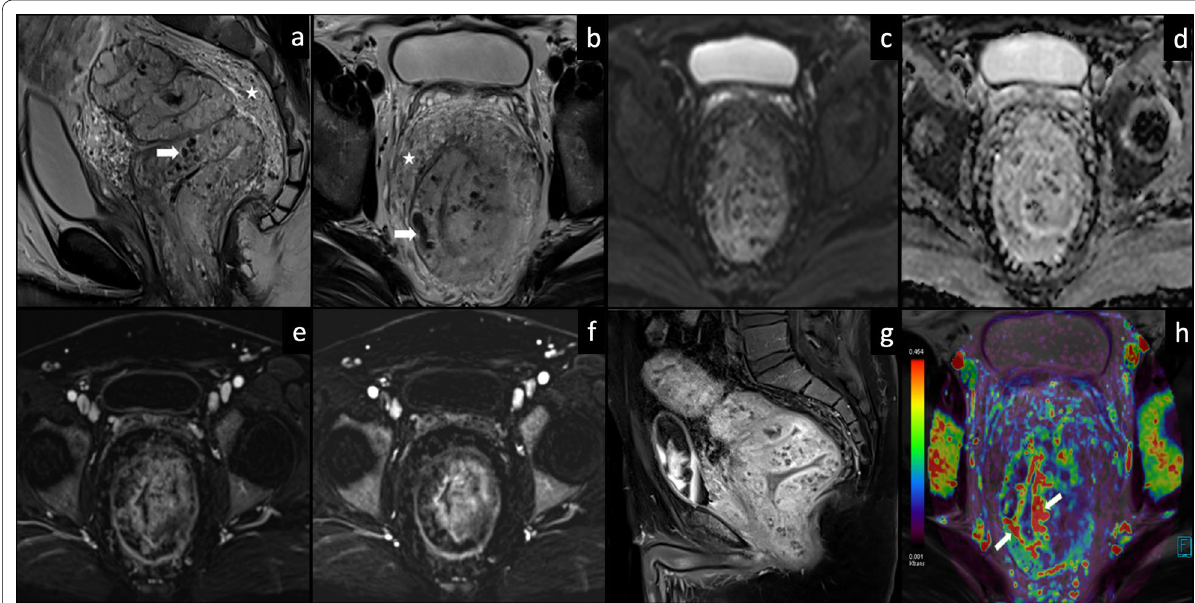
Fig. 2 The sagittal ( a ) and axial ( b ) T2W MR images show diffuse thickening in the wall of the rectosigmoid colon characterized by increased signal intensity. The hypointense serpiginous areas represent dilated tortuous venous structures (thick arrows), and multiple round hypointense foci represent phleboliths. The mesorectal fascia has increased heterogonous signal intensity (asterisk). The lesion does not show diffusion-restriction on DWI ( c ) and ADC map ( d ). The lesion does not show prominent early or late contrast enhancement on the axial dynamic contrast-enhanced T1W images ( e , f ). However, the sagittal delayed contrast enhancement image ( g ) reveals that the lesion has heterogonous diffuse contrast enhancement ( g ). Overall, the lesion shows decreased perfusion ( e ) interspersed with highly perfused areas consistent with the dilated venous structures (arrows) ( h